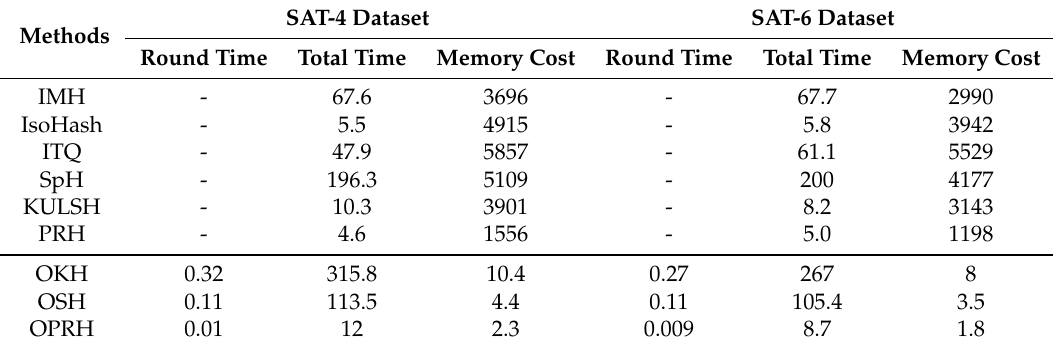
Table 3. The comparison of training time (in seconds) and memory cost (MB) for different kinds of hashing methods.